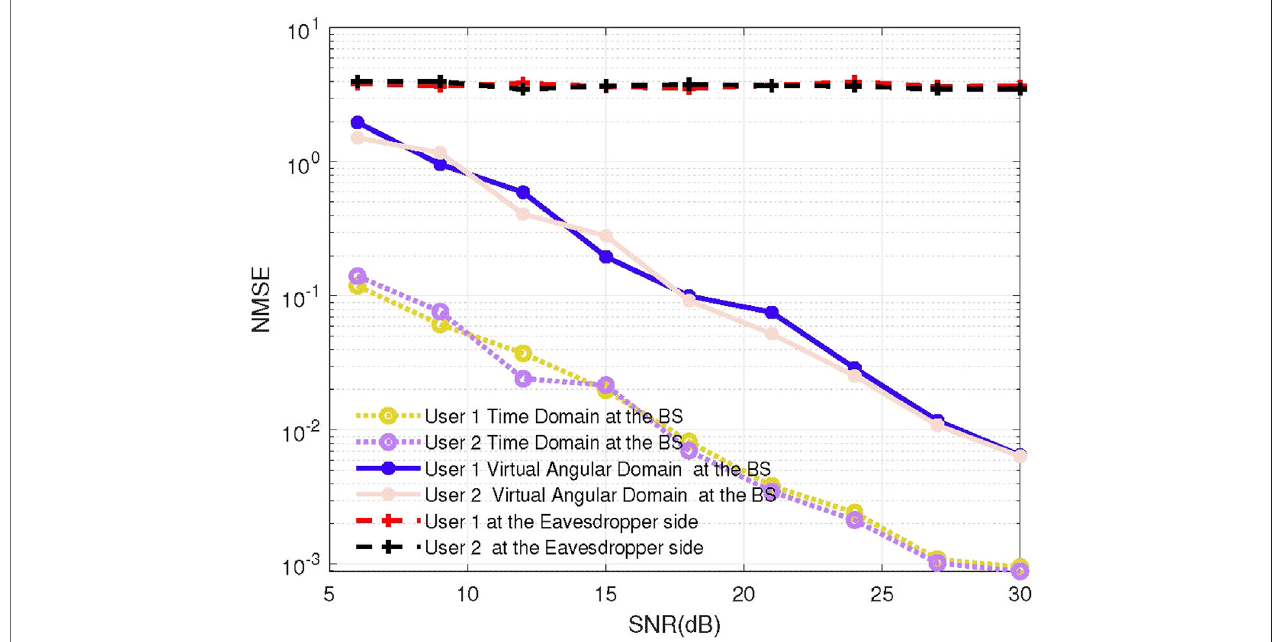
FIGURE3| Impact ofSNR forthe proposed scheme on theNMSE performanceofchannel estimation inthe time and virtual angular domain, where the number of BS antennas is set to 64.